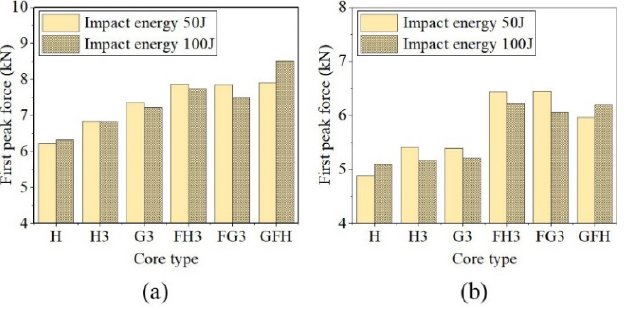
Figure 20. Peak force of various panels. (a) Hemispherical impactor. (b) Flat impactor.